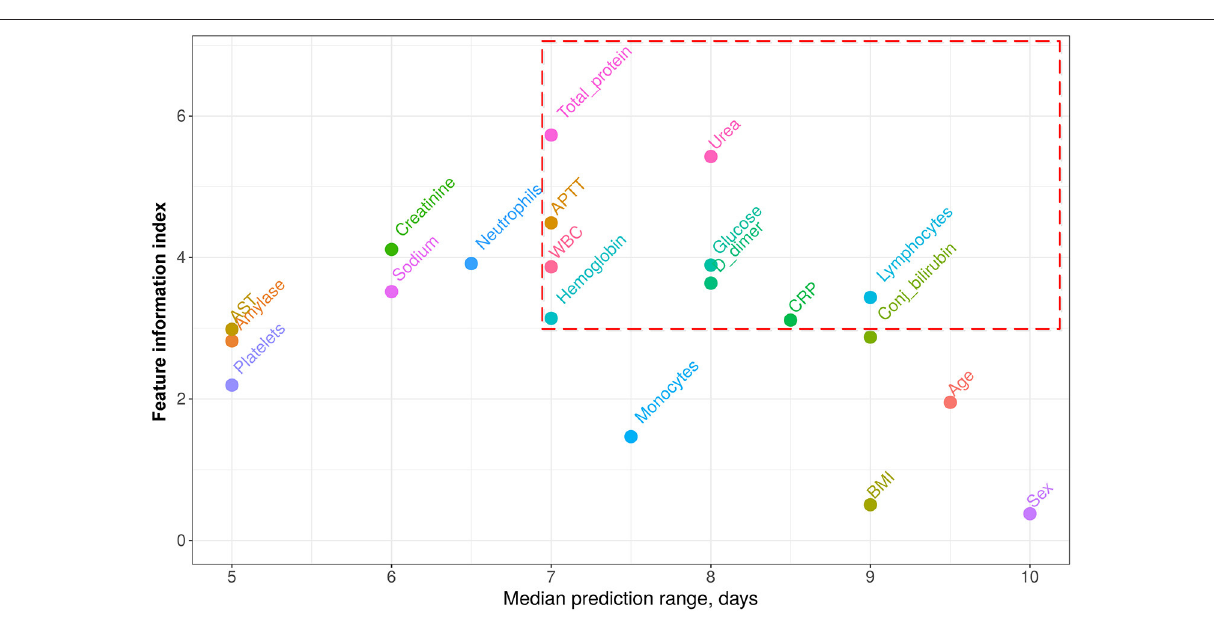
Table 2 . The score value is obtained as a sum of weights of those features, which values crossed the specified threshold. The score values range from 0 to 36